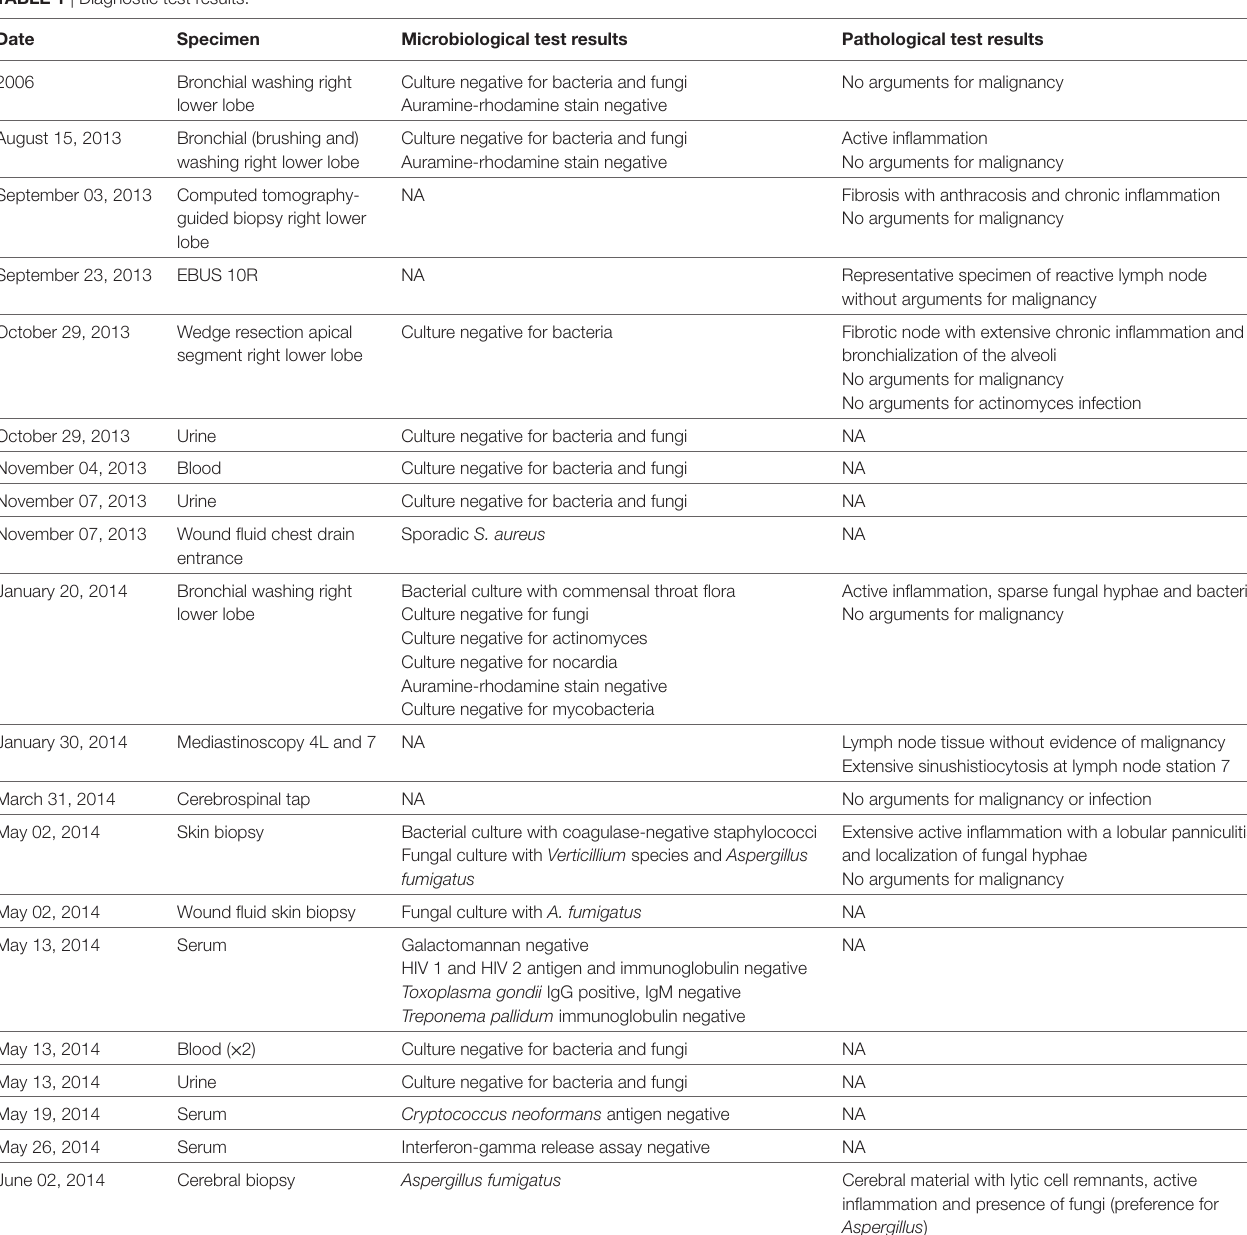
FIGURe 2 | Evolution of thoracic lesions. Top: Follow-up chest computed tomography (CT) in 2011 showing a right-sided lobulated pulmonary mass at the right lower lobe (3.0-cm diameter). Middle: CT (left) and fusion 18-fluordeoxyglucose positron emission tomography-computed tomography ( 18 FDG-PET-CT) (right) in August 2013 shows an increase at the medial side of the mass and right hilar lymphadenopathy, with intense 18-fluordeoxyglucose ( 18 FDG) uptake. Bottom: CT (left) and fusion 18 FDG-PET-CT (right) in January 2014 showing further growth of the 18 FDG-avid mass in the right lower lobe with hilar invasion and a mild 18 FDG-avid subcarinal lymph node. taBLe 1 | Diagnostic test